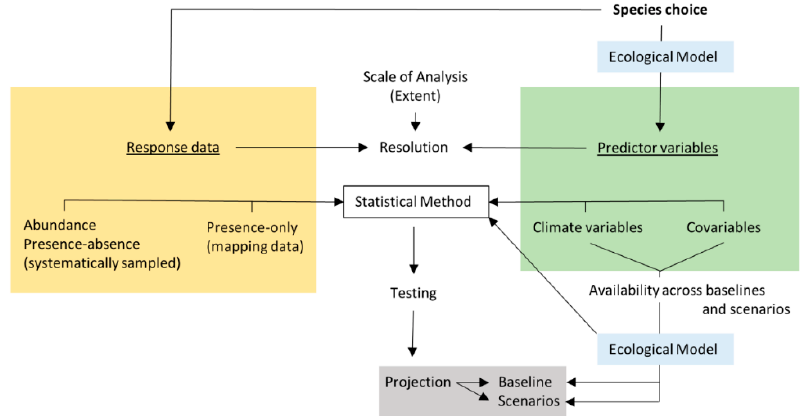
Figure 1. Example decision making framework for bioclimatic modelling; choice of species drives an initial ecological model that should consider how evidence from physiological studies might inform predictor variables (climate and covariables); species choice may also determine the relevant available distributional data, which needs to match at extent and resolution with the predictors; the ecological model (whether linear, nonlinear, with or without interactions) combines with the structure of response-predictor data to further determine the choice of statistical method; the statistical method is applied and tested and once validated is projected to the baseline and climate change scenarios; the use of scenarios can constrain the choice of predictors, in order to ensure that these are available at the same extent/resolution for both the baseline and climate change scenarios.